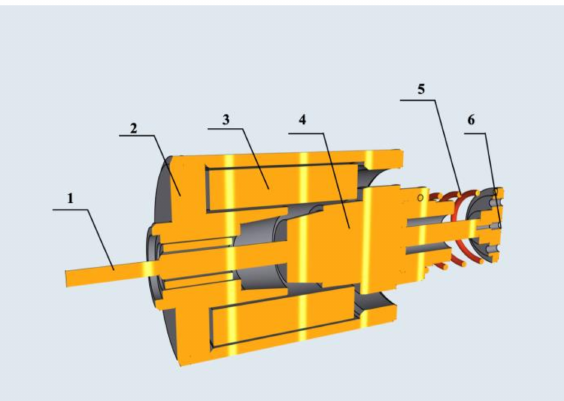
Figure 1. Structure drawing of electromagnetic actuator: (1) output linkage; (2) shell; (3) armature winding; (4) proportional electromagnet; (5) reset spring; (6) displacement